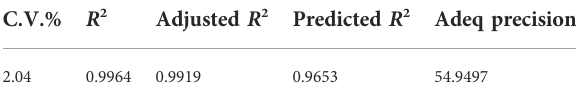
TABLE 8 Statistics for OD of RSM.